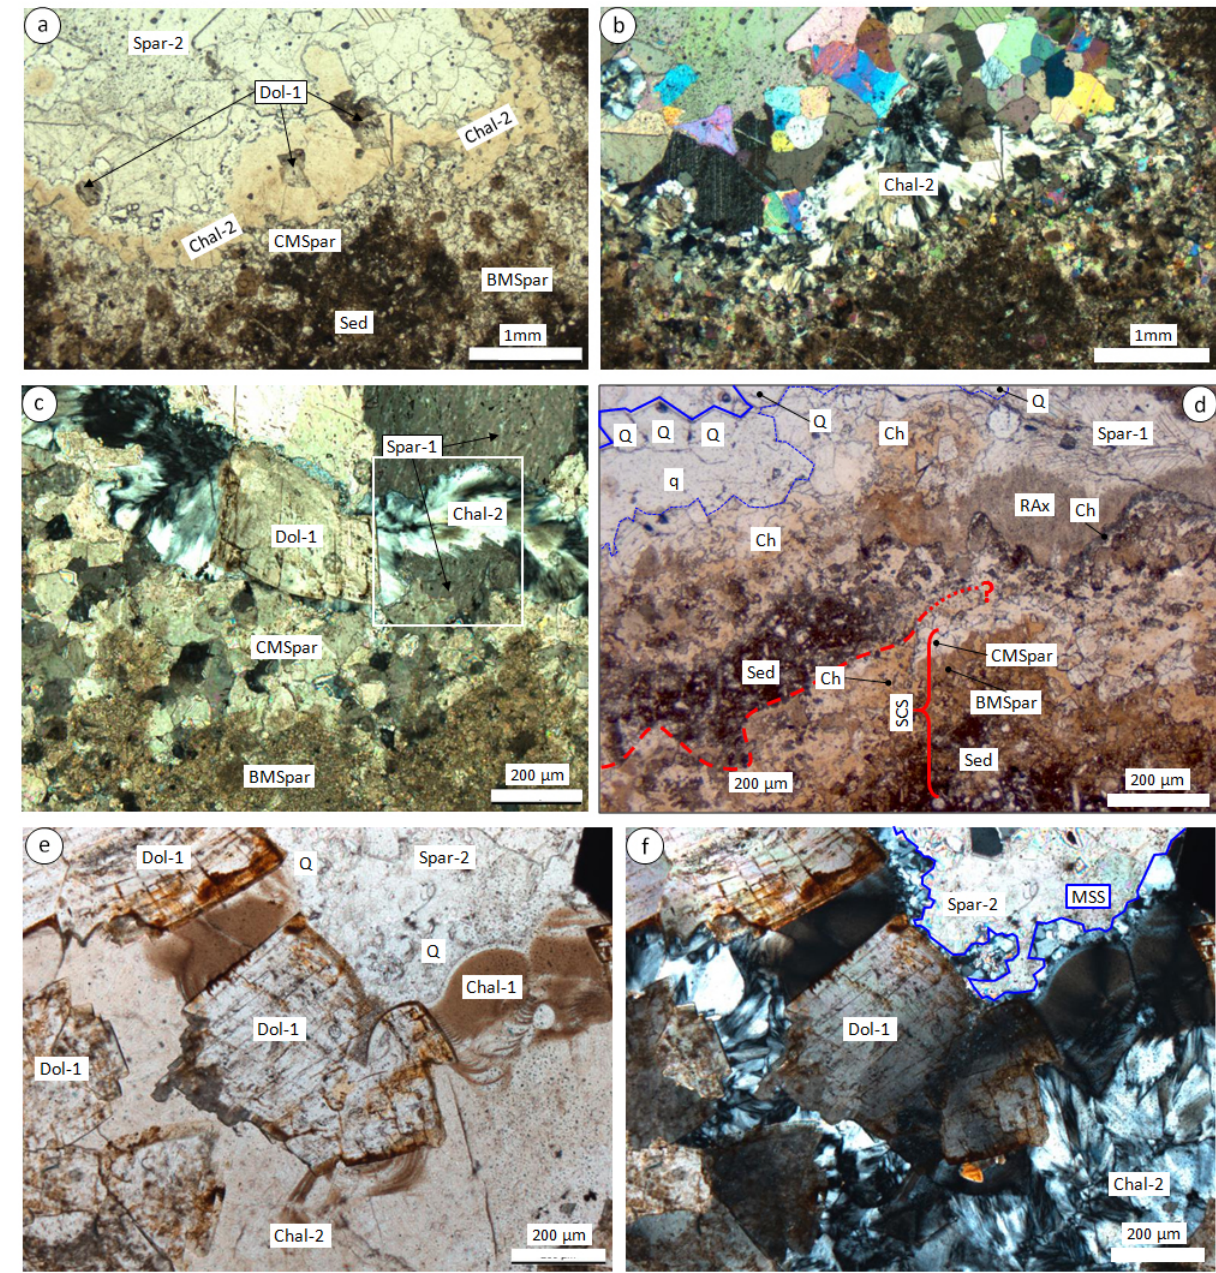
Figure 11. Cements within Phase-3 burrows and host sediment. (a, b) General view of burrow margin in plane-polarized light (a) and cross-polarized light (b) . Note continuous rim of beige chalcedony (Chal-2) associated with saddle dolomite (Dol-1); BMSpar and CMSpar: brown and clear microspar, respectively; Sed: sediment. (c) Details of the relationship between Chal-2 and carbonate cements in cross- polarized light; Spar-1: first generation of sparite cement; the white rectangle: Chal 2 cutting across a single sparite crystal. (d) Burrow rim in plane-polarized light showing one sediment–cement sequence (SCS, red bracket) capped by sediment in the left part. The cements are heavily replaced by chalcedony. Red line: top of SCS, dashed where observed and dotted where inferred. Radiaxial gray calcite crystals (RAx) locally cap the SCS. Blue lines (dashed at base, solid at top) outline a patch of quartz with anhedral (q) capped by euhedral (Q) crystals; euhedral crystals are aligned roughly parallel to burrow margin wall. (e, f) Main phases of silicification in plane-polarized light (e) and cross-polarized light (f) ; Chal-1: botryoidal chalcedony precipitated freely at the tube wall, Q: euhedral quartz also overgrown on a free surface, Chal-2 and the associated saddle dolomite Dol-1 replaced both preexisting carbonates and Chal-1. Note the extinction pattern of Chal-2 characterizing “flamboyant chalcedony”. The blue zigzag line marks the main silicification surface (MSS). For details, see the text.